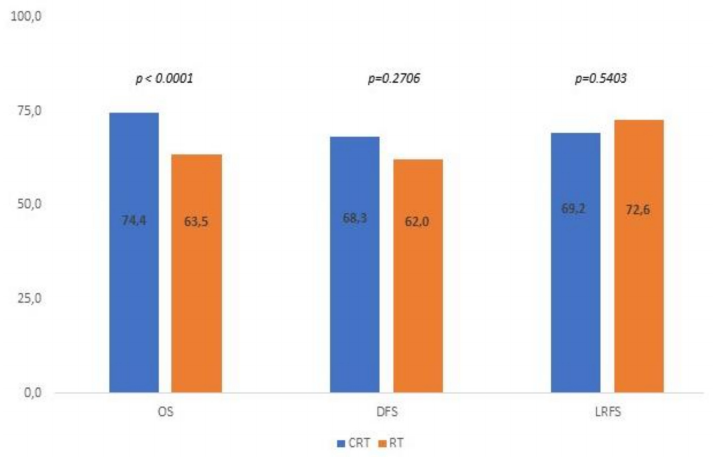
Figure 5. p values for OS, DFS, and LRFS for all analyzed